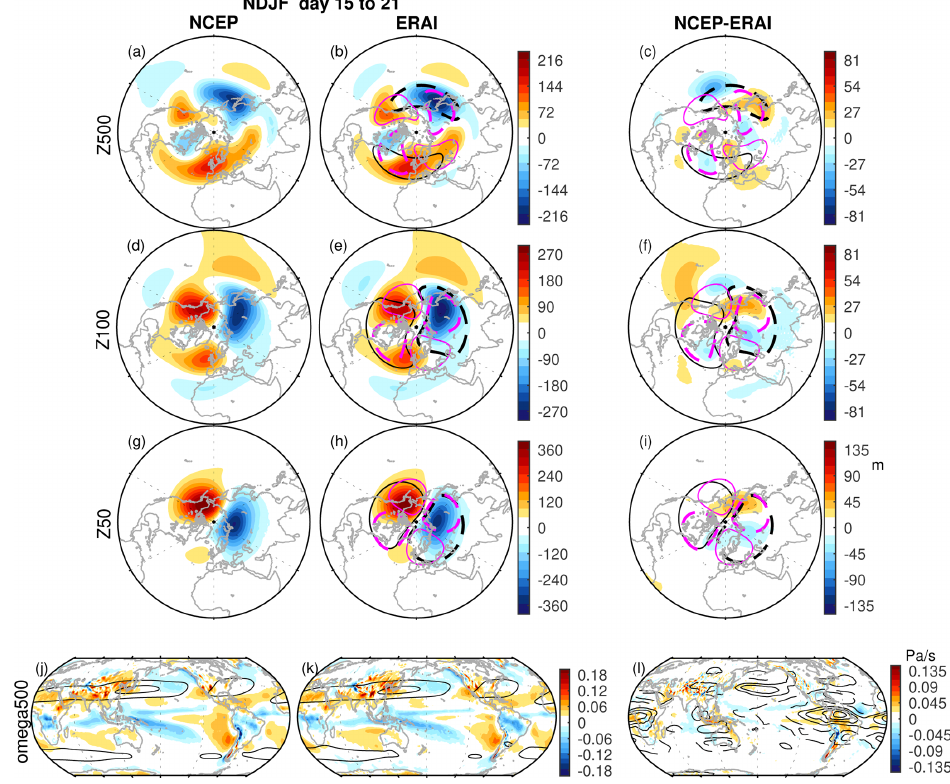
Figure 4. Top: anomalies from zonal mean of geopotential height (m) during week 3 for initializations during NDJF in the NCEP model at (a) 500hPa, (d) 100hPa, and (g) 50hPa. The middle column (b, e, h) is for ERA-I subsampled to match the dates chosen for NCEP; the right column (c, f, i) is for the difference between ERA-I and NCEP. Bottom: ω (color) and zonal wind (contours) during week 3 for initializations during NDJF (j) in the NCEP model, (k) for ERA-I to subsampled to match the dates chosen for NCEP, and (i) the difference between ERA-I and NCEP. Black and magenta contours denote the stationary wavenumber 1 and wavenumber 2 components in ERA-I with contour intervals of ± 60 and ± 40m, respectively, with dashed (solid) contours representing negative (positive) anomalies. Contour intervals in panels (j) and (k) are at 30 and 60ms − 1 and in panel (l) are at ± 2, ± 4, ± 6, ± 8, and ± 10ms − 1